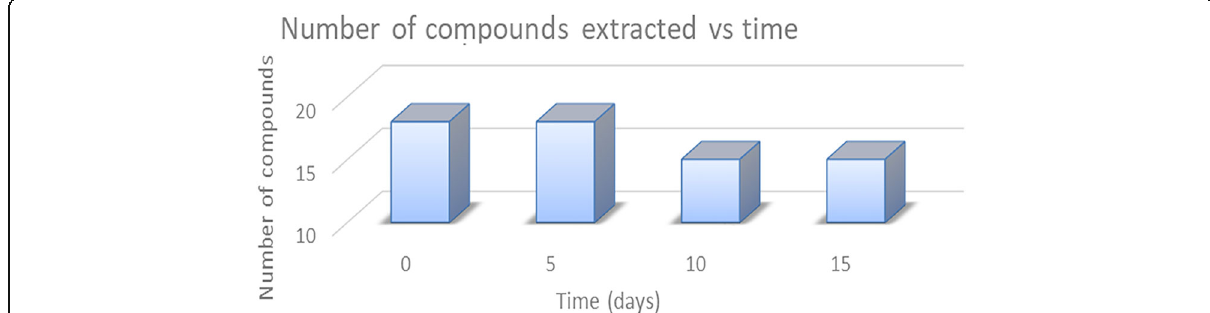
Fig. 3 Number of compounds extracted from fresh and aged samples